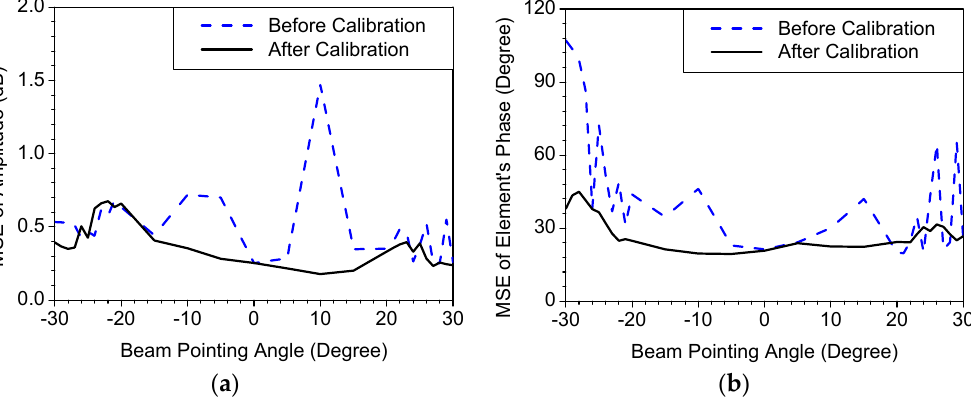
Figure 13. Mean square errors calculated from the back-projected fields on the antenna radome surface: ( a ) amplitude and ( b ) phase response.